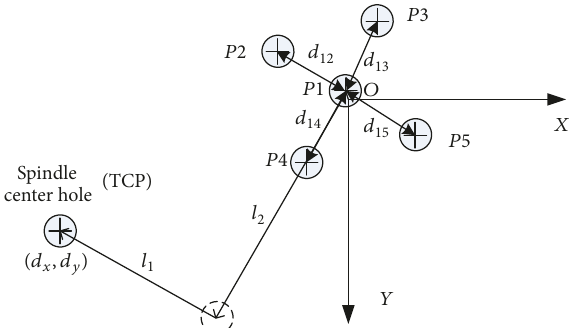
Figure 3: Position of spindle center hole (TCP).